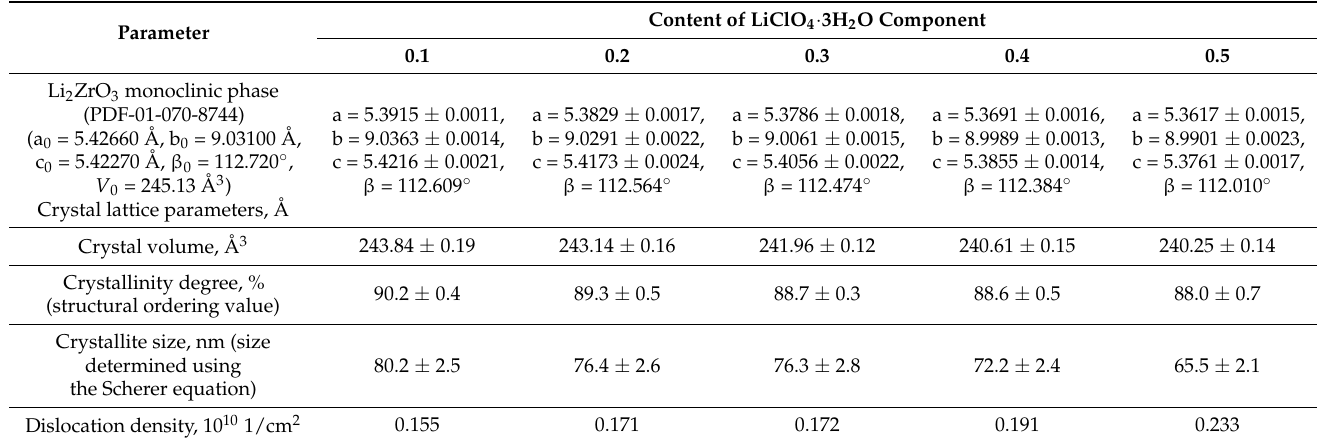
Table 1. Unit-cell parameters and crystallinity characteristics for Li 2 ZrO 3